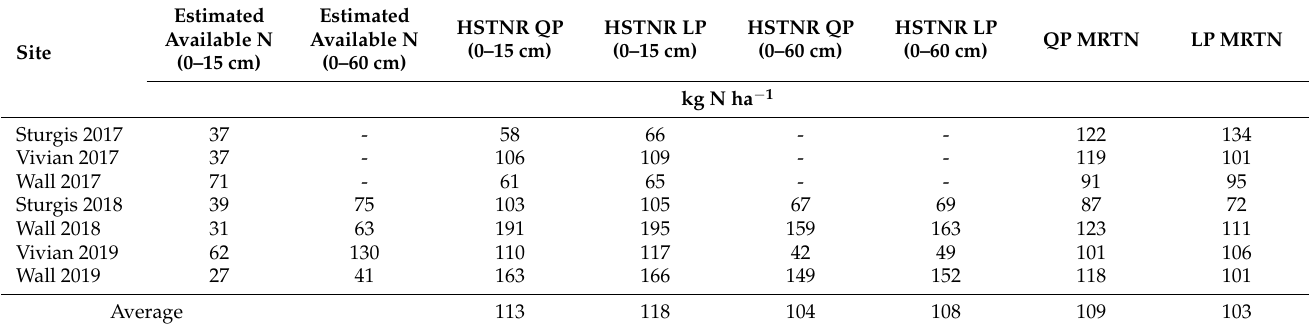
Table 3. Estimated nitrogen rate (kg ha − 1 ) for the linear plateau (LP) and quadratic plateau (QP) models at the estimated Haney Soil Test (HST) and MRTN values.